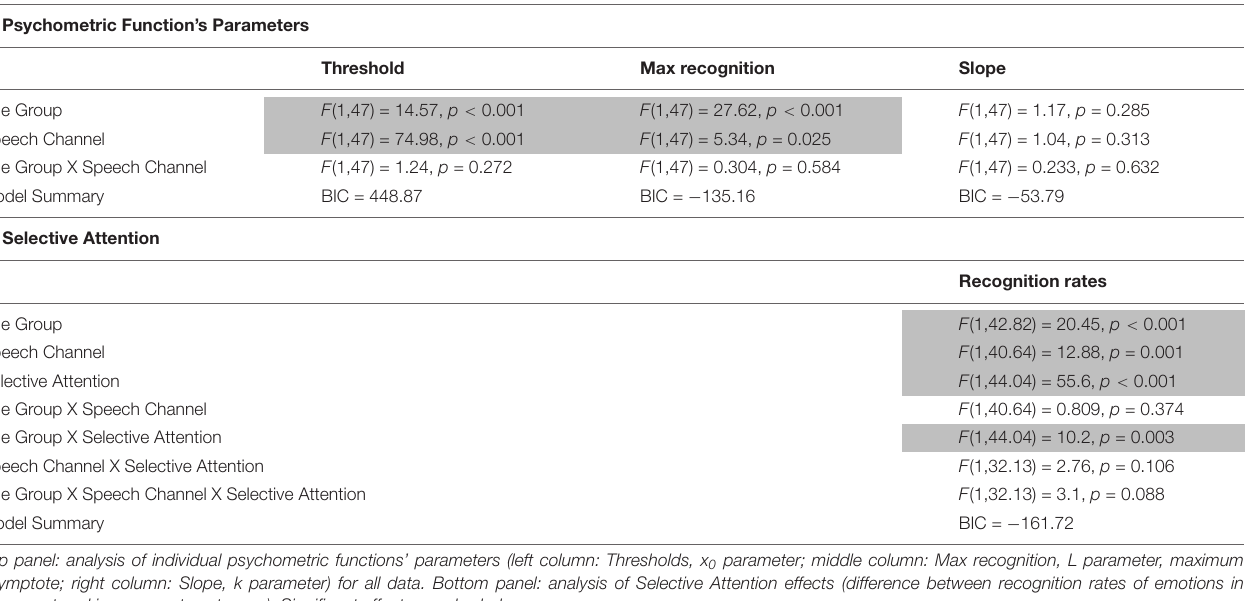
Frontiers in Neuroscience |